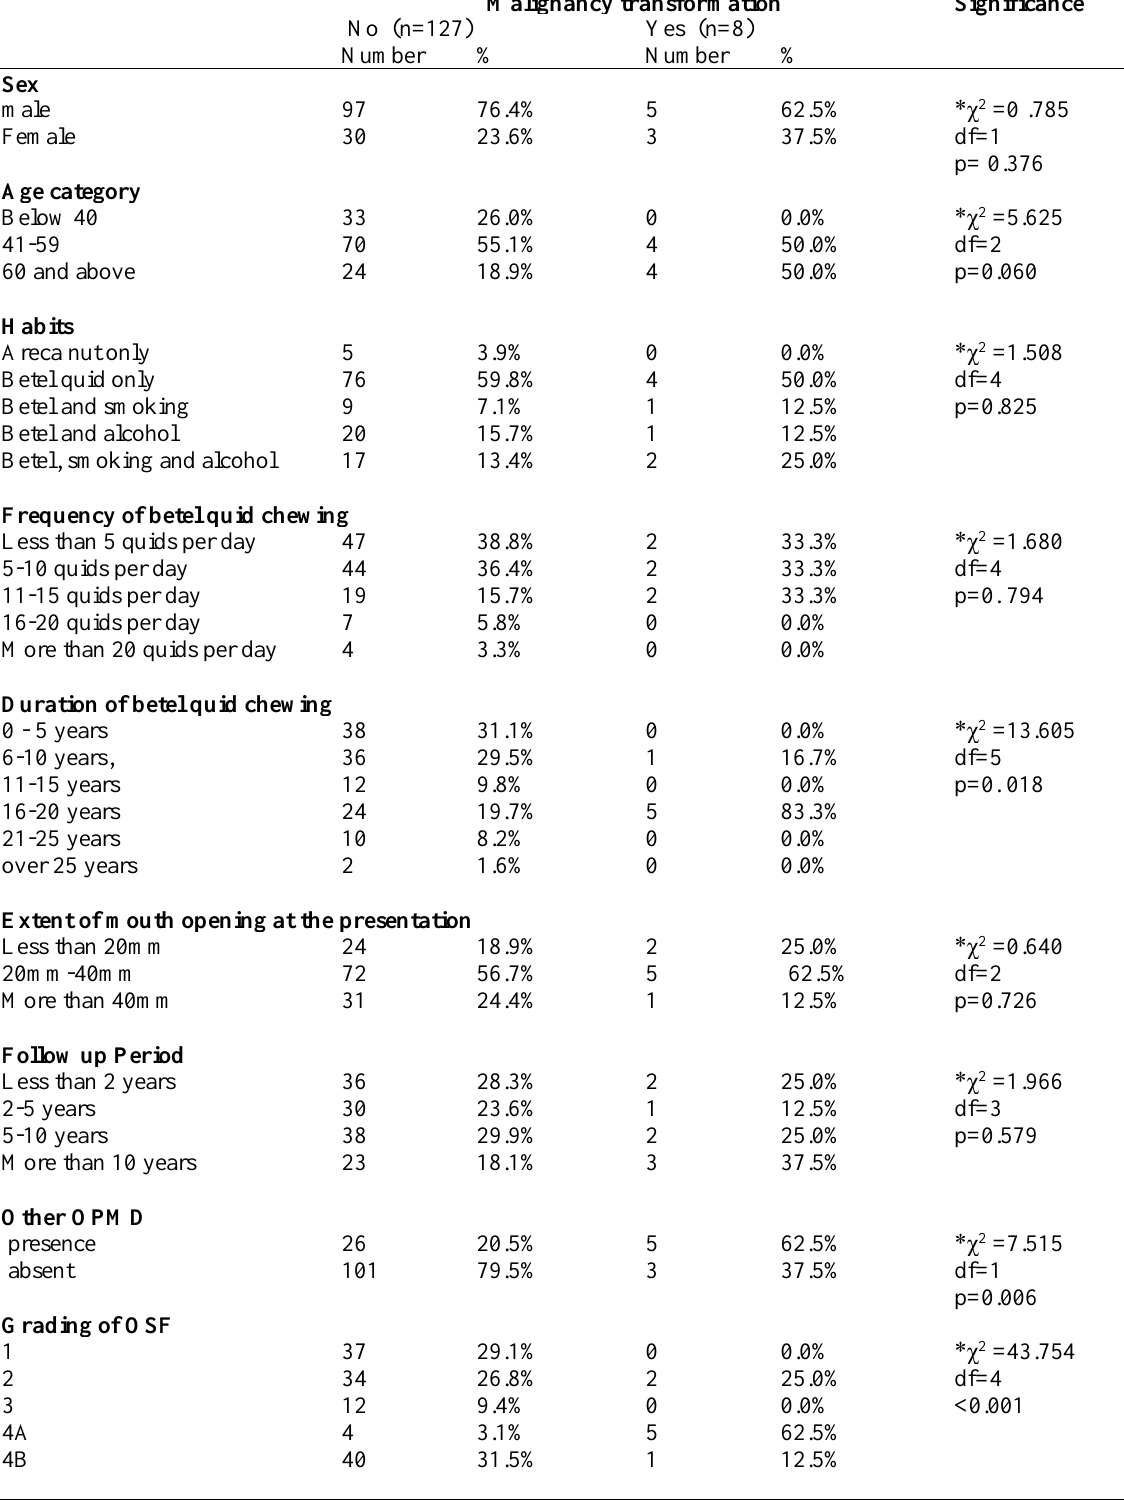
Table 3: Association of malignant transformation with the different parameters of the patients Malignancy transformation